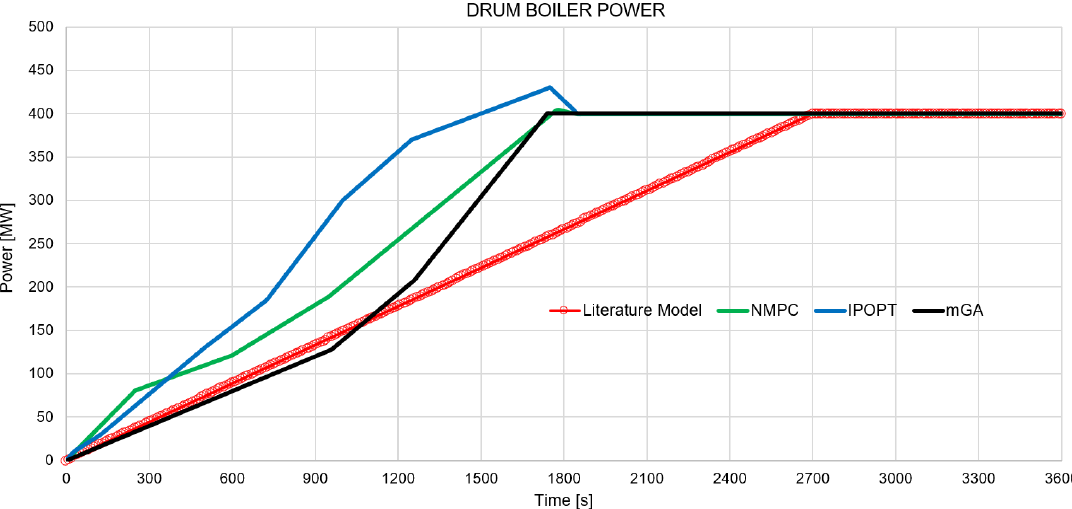
Figure 21. Results comparison between the curves of the operating reference profile available in the literature (red line), the optimized profiles reported by [17] (green line) and [20] (blue line), and the proposed approach (black line) for the power